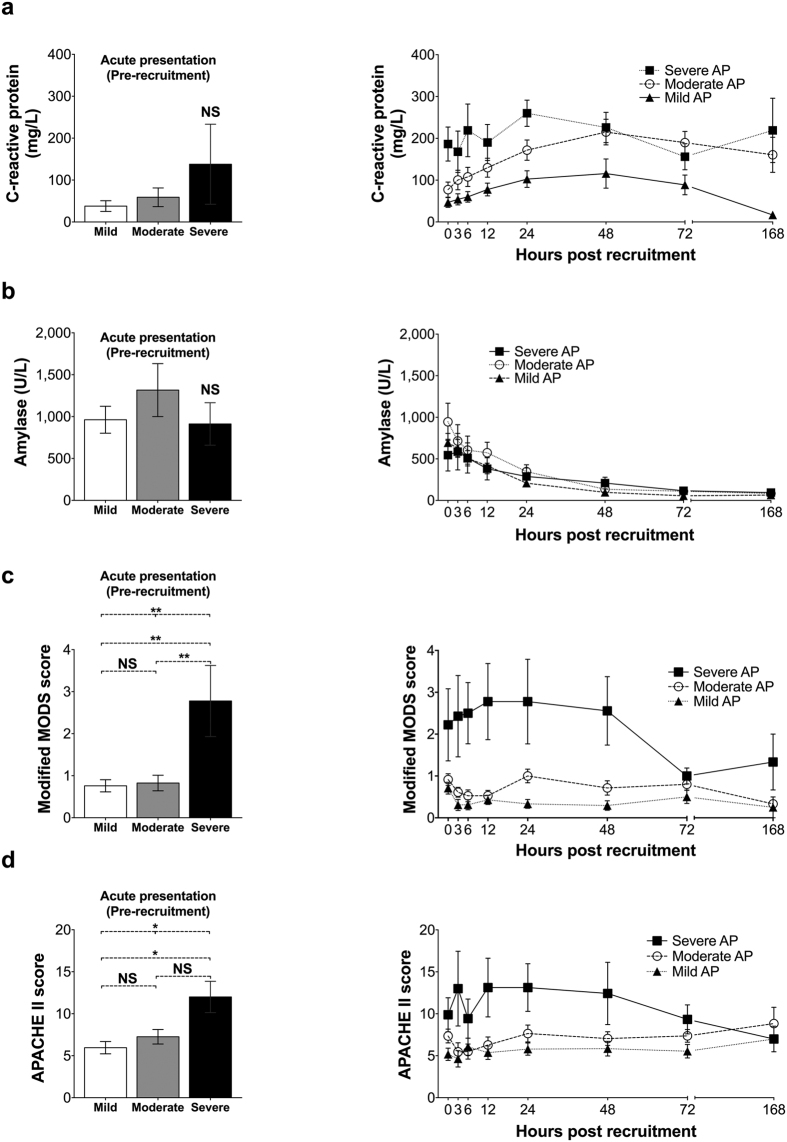
Panel of comparisons between mild (n = 25), moderate (n = 23) and severe AP (n = 9) participant groups for (a) C-reactive protein; (b) Amylase; (c) Modified MODS score (as described in the revised Atlanta guidelines); (d) APACHE II score. Bar charts on the left hand side of the panel represent Tminus sample means (acute presentation – pre-recruitment), while right-hand side plots depict the time-course for each variable mean per participant group. NS: not statistically significant difference; *0.05 > P > 0.01; **P < 0.01; error bars represent standard errors of the mean.